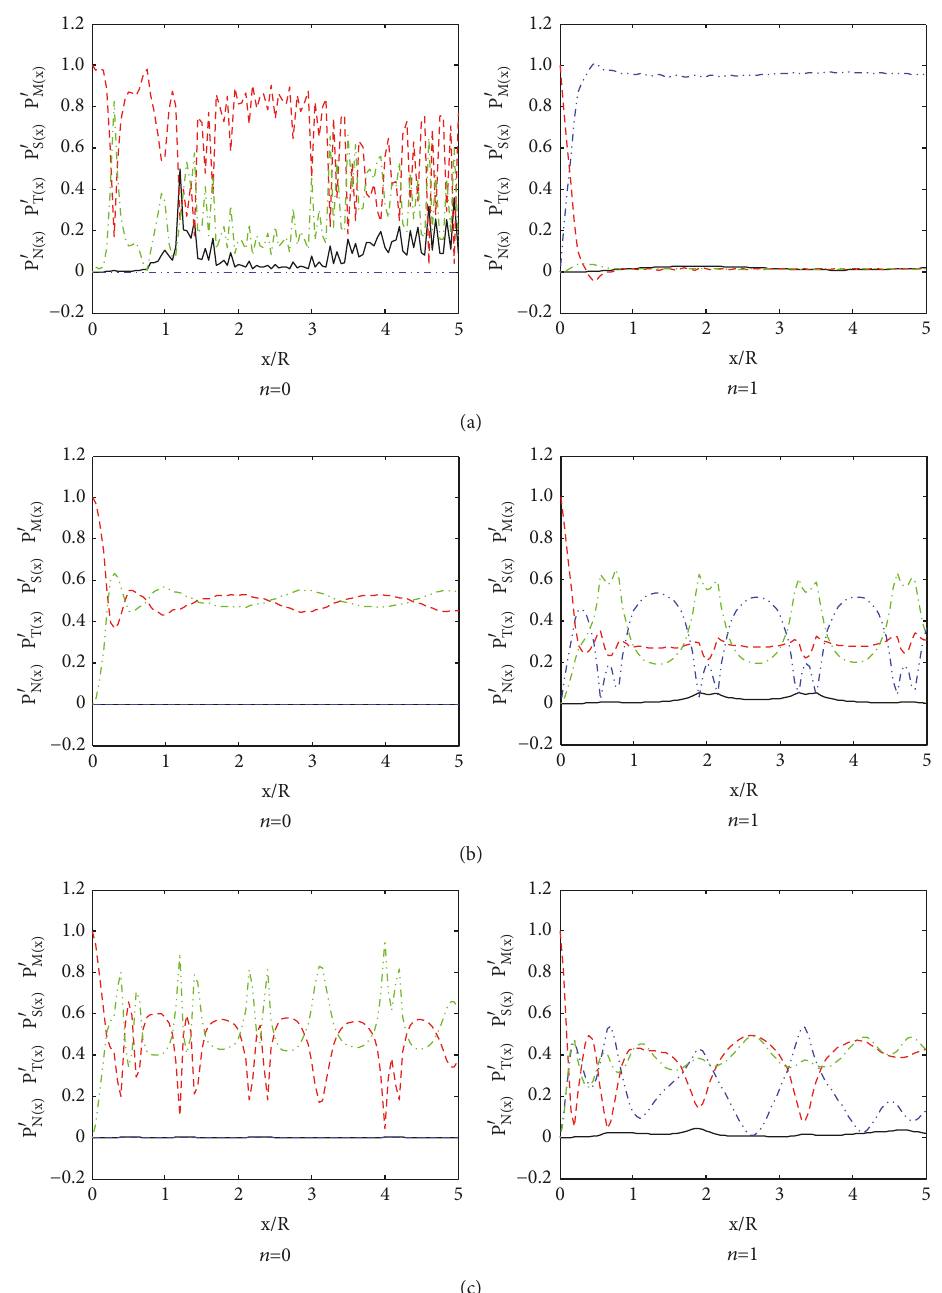
Figure 9: Power transmitted by different shell forces (moments) with 𝐸 2 /𝐸 1 =15: (a) Ω = 0.3 , (b) Ω = 1.2 , and (c) Ω = 3.0 ; black solid line: 𝑃 󸀠 𝑆(𝑥) ; blue dashed double dotted line: